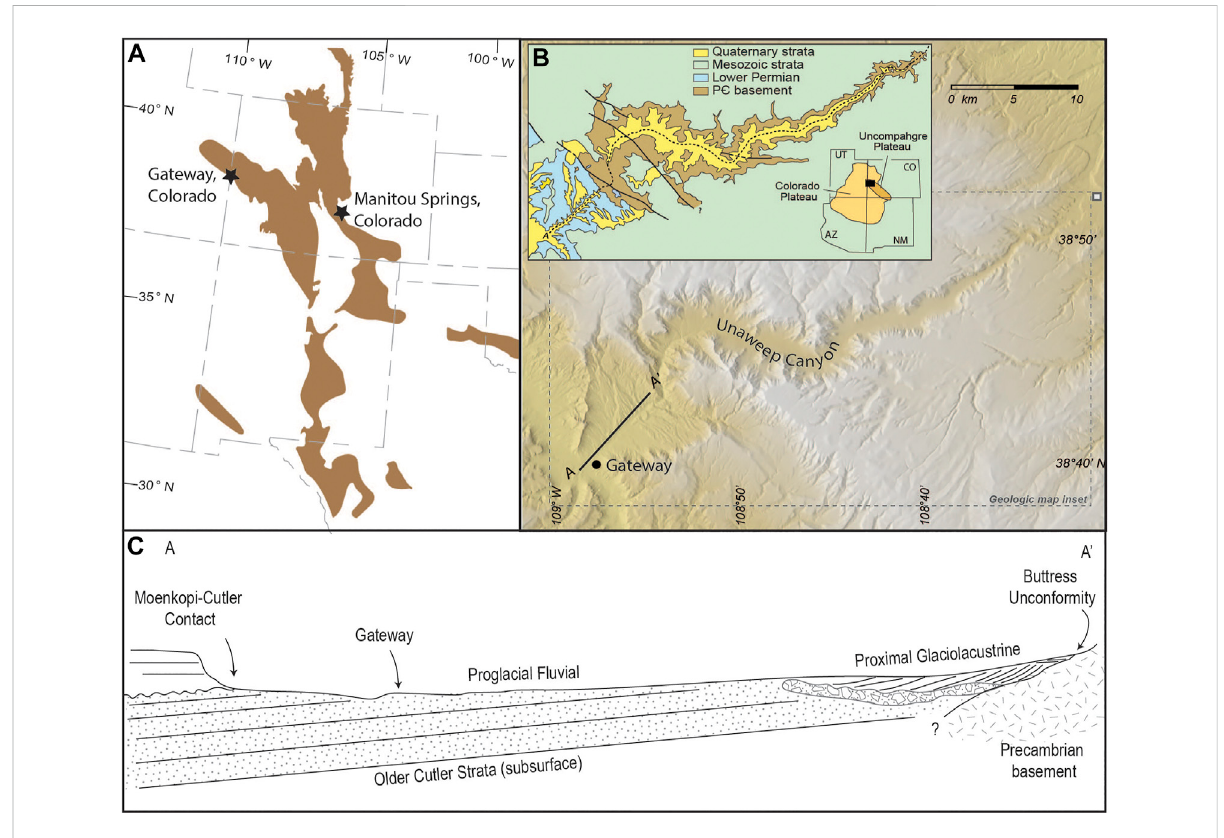
FIGURE 2 Location map and depositional architecture of the proximal Cutler Formation. (A) Upland areas during the late Paleozoic (brown polygons). Proximal Cutler and Fountain formations discussed in text are located near the towns of Gateway and Manitou Springs, Colorado, respectively. (B) Digital elevation model (DEM) of the Gateway, Colorado region. Unaweep Canyon is interpreted as a glacially carved valley dating from the late Paleozoic and partially reburied; the Cutler Formation, exposed near Gateway, Colorado, is interpreted to have accumulated when Unaweep Canyon was occupied by ice. Inset: Geologic map of the dashed rectangle depicted on the DEM. (C) Cross-section (A-A ′ ) depicting the variation in facies from (inferred) most proximal glaciolacustrine to distal proglacial fl uvial. The latter is the focus in the text. Line A-A ′ is shown on (B)